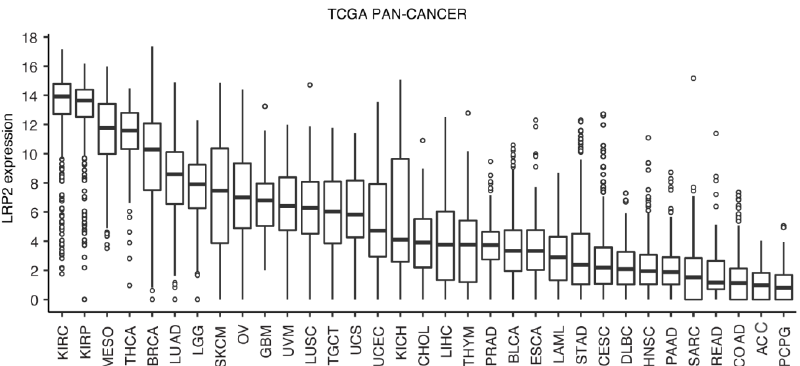
Figure 1. LRP2 expression across human cancers. Boxplot of LRP2 expression (RSEM norm_count log2 transformed with offset of 1) across each cancer type in the TCGA Pan-Cancer dataset. Boxplot lines represent lower quartile, median, and upper quartile. Whiskers represent 1.5 times above or below interquartile range. Points reflect outliers. Full list of cancer type abbreviations is provided in Table S1.